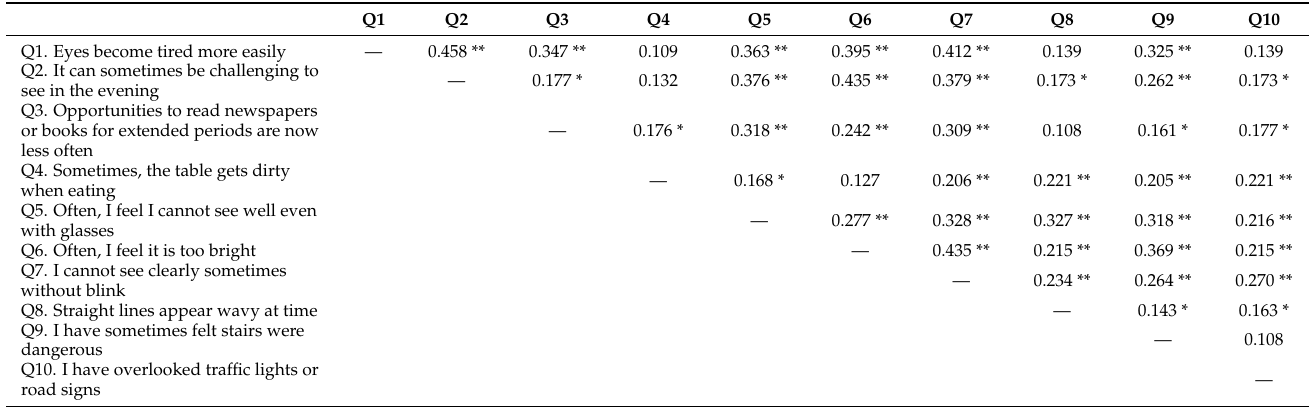
Table 1. Correlation matrix among eye frailty self-check items.